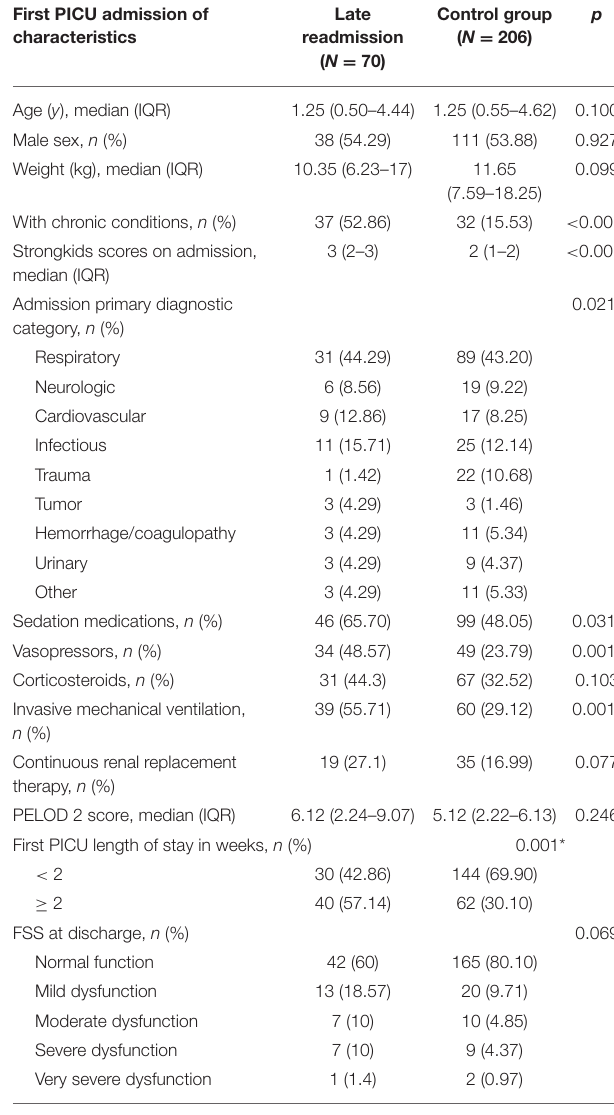
TABLE 5 | Risk factors of late readmission associated with characteristics on first PICU admission.